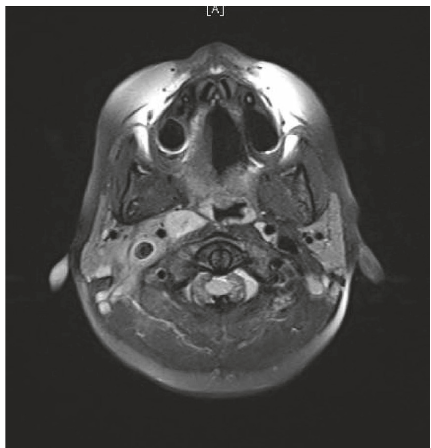
Figure 1: Horizontal section of the MRI of the brain.